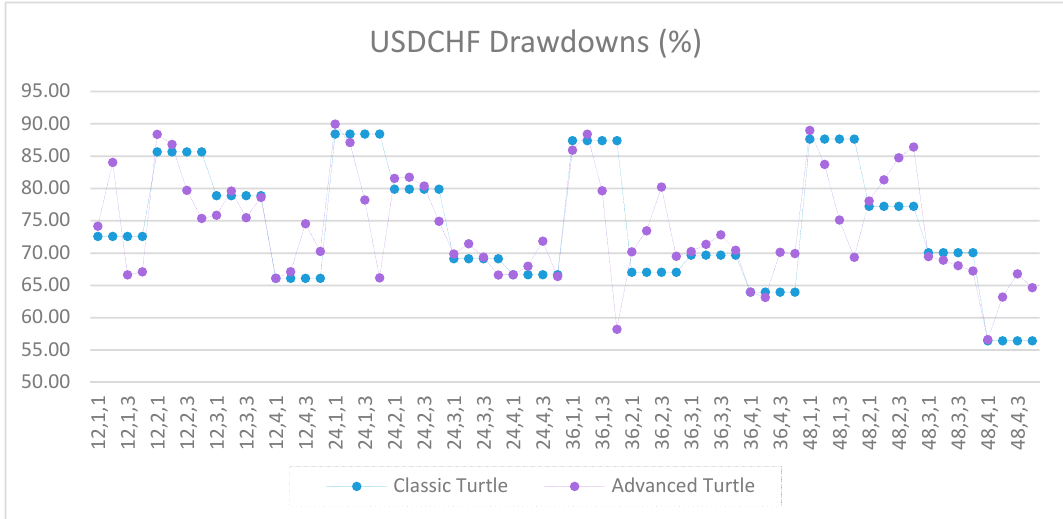
Figure A39. Net profits of USDCHF between the classic and the advanced Turtle systems for every combination of N, X, Y for the slow parameters (80, 160).